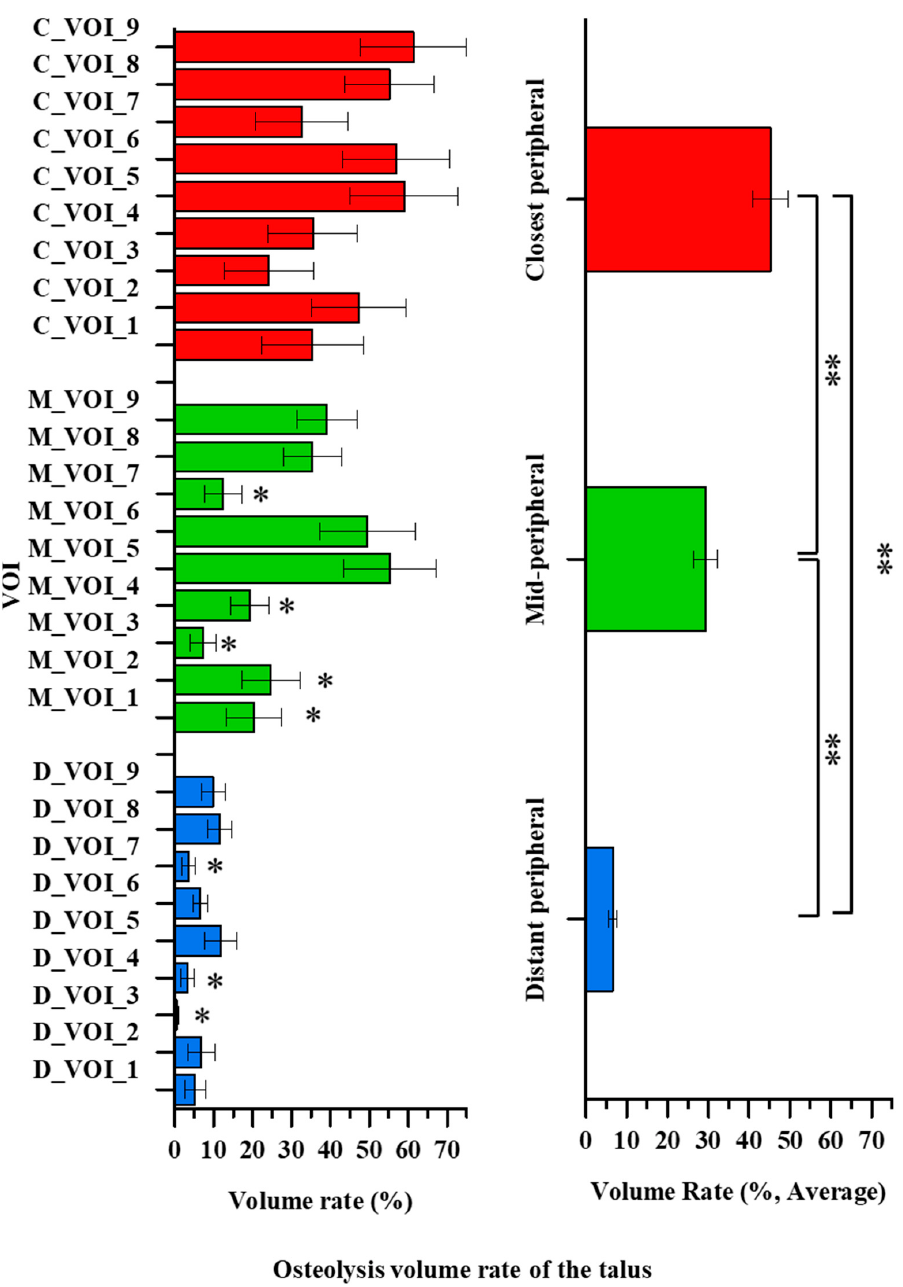
Figure 5. The average talus osteolysis volume of the 12 patients. Significant differences are indicated by double asterisks (one-way ANOVA followed by Fisher’s LSD test, p < 0.05). Single asterisks indicate a significant difference compared to the center region (C_VOI_5, M_VOI_5 or D_VOI_5) ( p < 0.05).